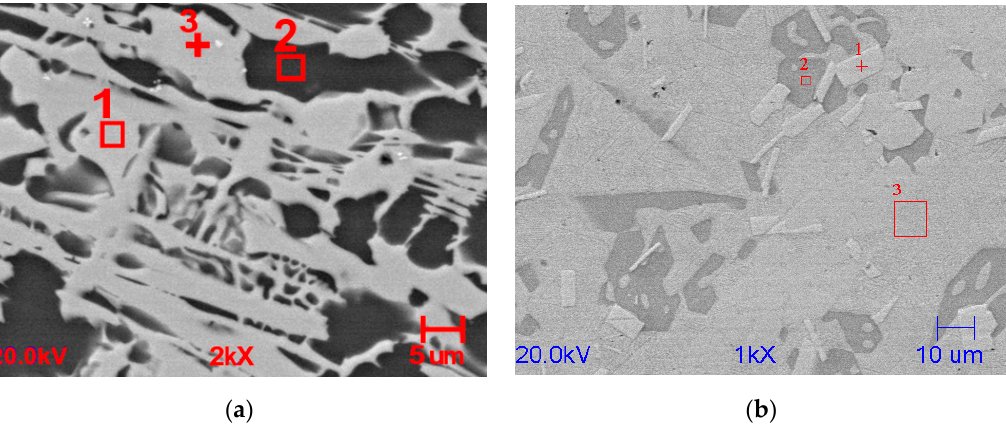
Figure 1. SEM/EDS images revealed after mechanical polishing for Mg 72 Zn 24 Ca 4 ( a ) and Zn 87 Mg 9 Ca 4 ( b ) alloys, respectively.